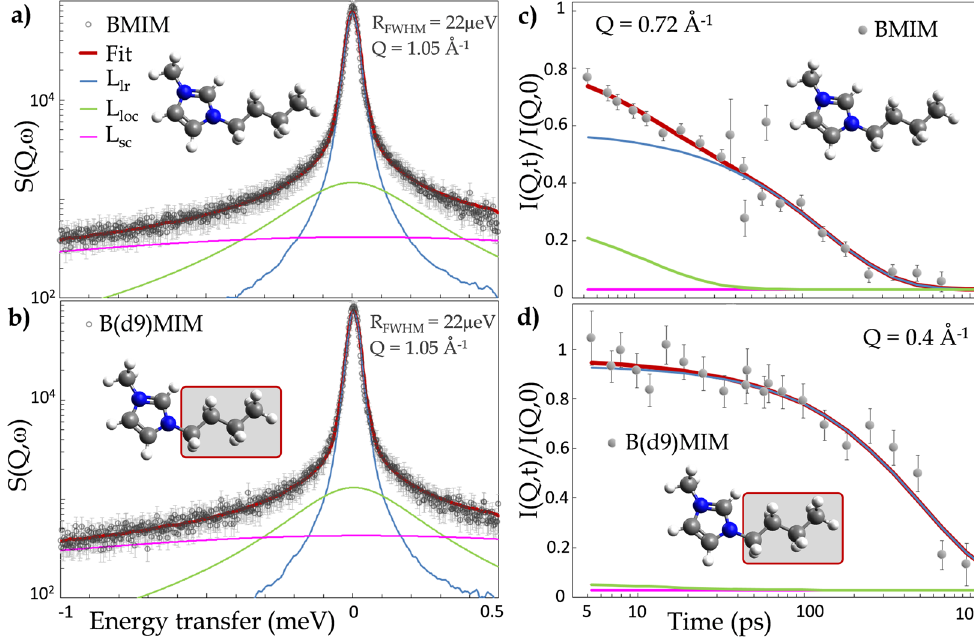
Figure 2. (a) ToF spectra (LET, ISIS, Chilton-Didcot, UK) of bulk BMIM-TFSI. The red thick line is the fit by Eq. (1) and the three dynamical contributions are shown: side-chains (Eq. S4, pink line), local diffusion within an aggregate (Eq. S5, green line) and long-range diffusion of the whole cation (Eq. S8, blue line). (b) Same as (a) but on the sample with selectively deuterated alkyl side-chain: B(d9)MIM-TFSI. (c) and (d) Same sample as (a) and (b) respectively but in the nanosecond time range by NSE (IN11, ILL, Grenoble).